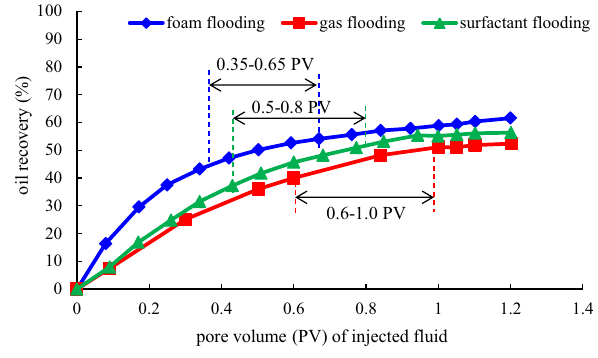
Fig. 8 The predicted oil recovery of different EOR techniques by rapid evaluation